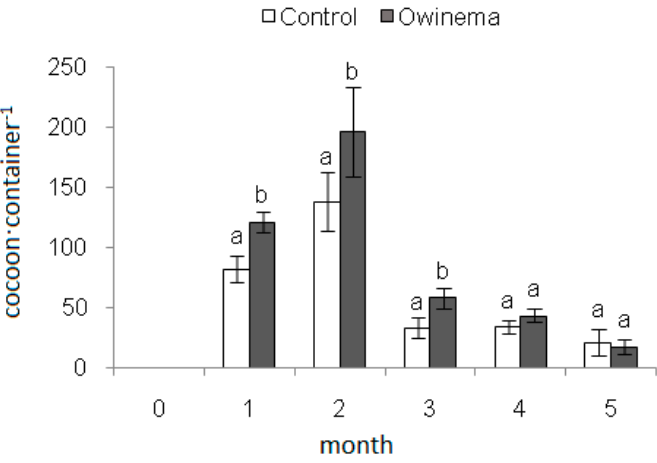
Figure 4. Mean number of E. fetida cocoons (cocoons · container − 1 ± SD) in experimental ecological boxes depending on the presence of an Owinema bio-preparation (50 mln larvae m − 2 ) during a 5 month experiment (a, b indicate significant differences between two means).